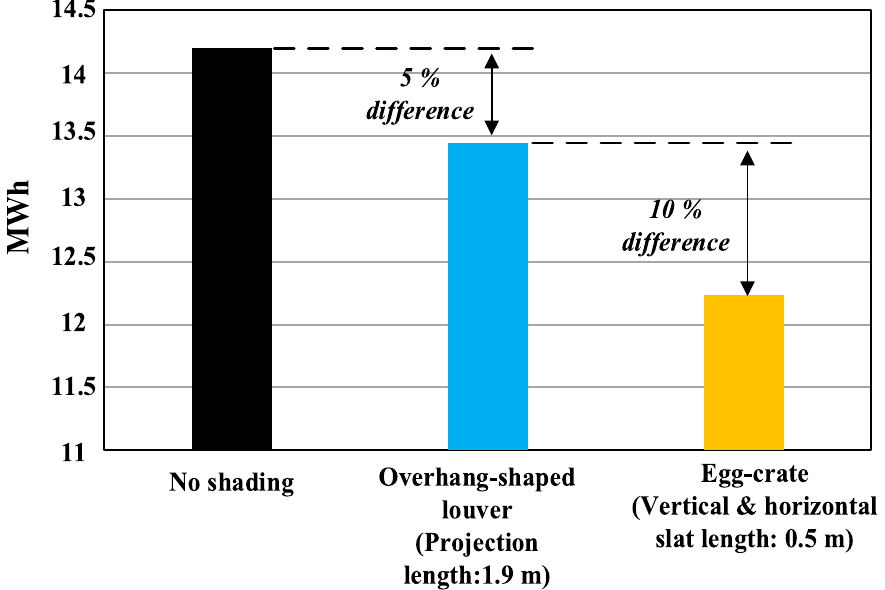
Figure 10. The reduction of artificial lighting energy consumption by two shading devices.